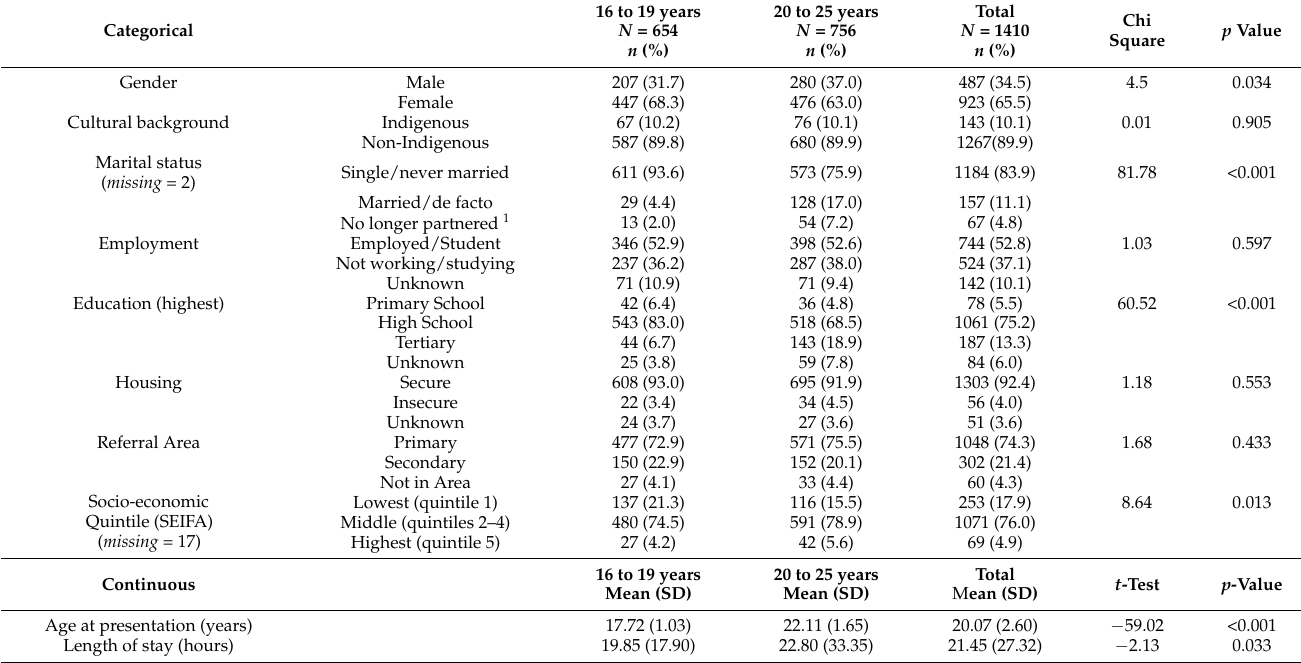
Table 1. Demographic characteristics by age strata (Adolescents vs. Young Adults).